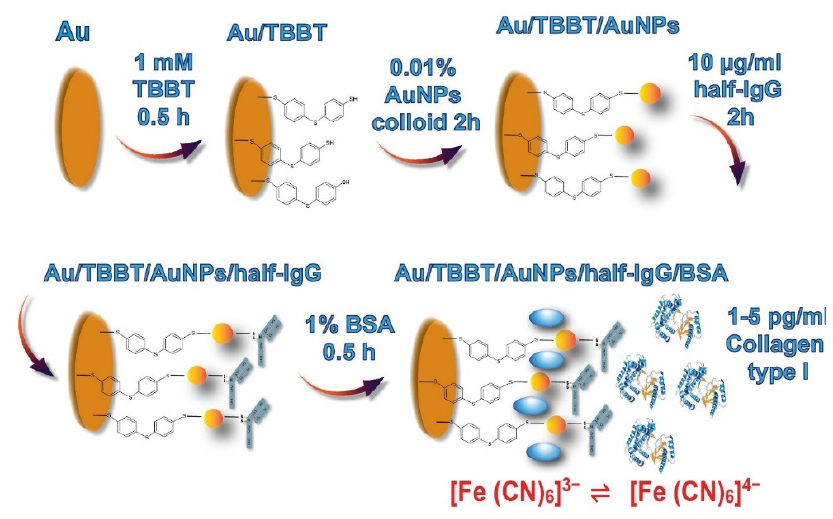
Figure 2. Illustration of the enzymatic reduction of the monoclonal antibody IgG by the disulphide- bridge-bond-breaker TECP (tris(2-carboxyethyl) phosphine hydrochloride) [63].